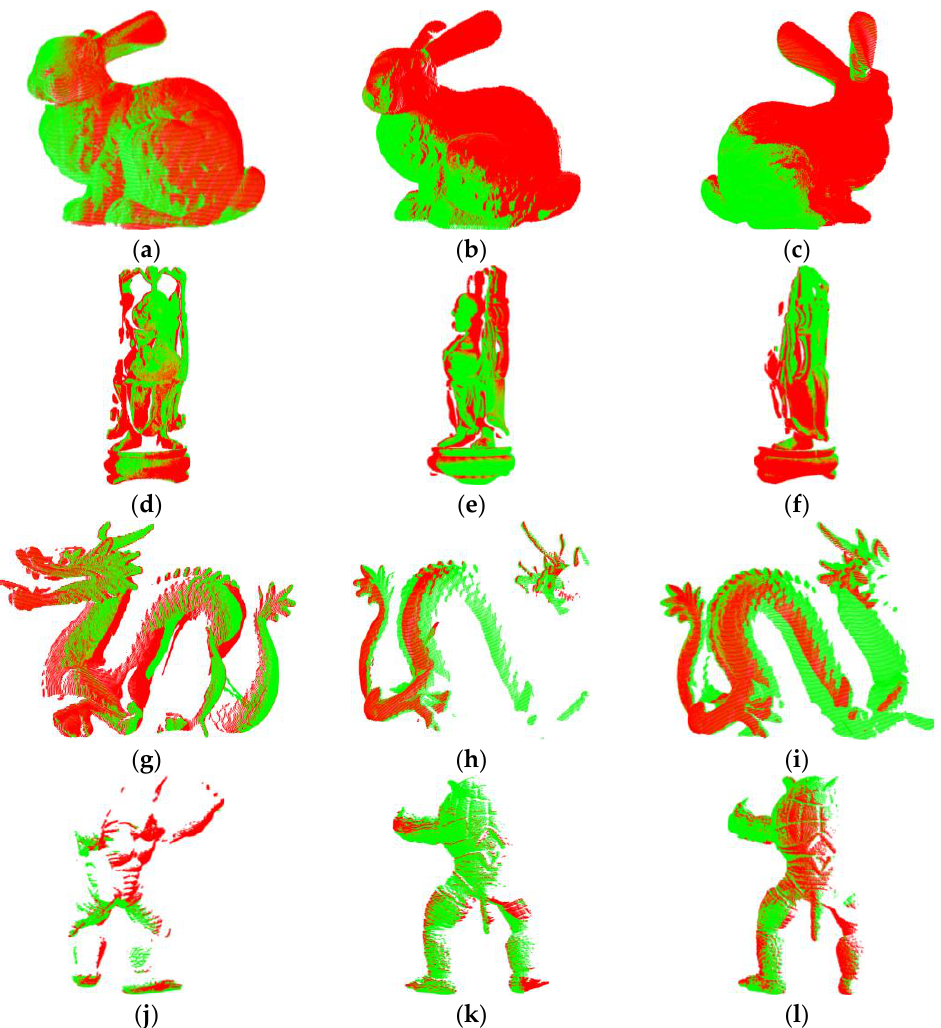
Figure 11. Point cloud registration examples of different datasets: ( a – c ) Point cloud registration examples of Bunny; ( d – f ) Point cloud registration examples of Buddha; ( g – i ) Point cloud registration examples of Dragon; ( j – l ) Point cloud registration examples of Armadillo.